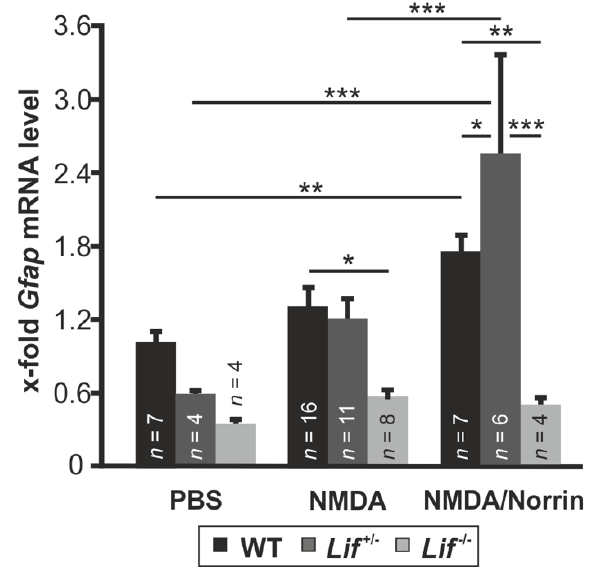
Figure 4. Norrin mediates Müller cell gliosis via Lif signaling. Real-time RT-PCR on retinal total RNA for Gfap from heterozygous ( Lif +/ − ) and homozygous, Lif-deficient mice ( Lif − / − ), as well as wild-type (WT) littermates 7 h after intravitreal injection of 3 µL PBS, 3 µL NMDA [10mM] or 3 µL NMDA [10 mM] with Norrin [5 ng/µL]. * p < 0.05; ** p < 0.01; *** p < 0.001.